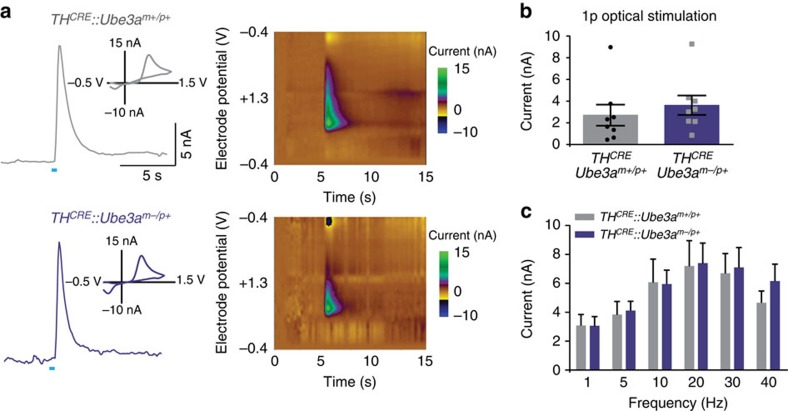
Optically evoked dopamine release is similar in TH-positive VTA-to-NAc terminals in Ube3am−/p+ and Ube3am+/p+ mice.(a) Representative fast-scan voltammetric recordings from ventral striatal slices in both THCRE::Ube3am−/p+ and THCRE::Ube3am+/p+ mice. Insets represent background-subtracted electrochemical signal characteristic of oxidized dopamine. Right: consecutive background-subtracted voltammogram recorded over an 8-s interval. Applied electrode potential (Eapps versus Ag/AgCl reference electrode) is shown versus time. (b) Light-evoked current is similar in both genotypes at 1 pulse (Student's t-test, P=0.99, n=8, 9) and (c) across a range of frequencies (one-way ANOVA, P=0.83, n=11, 12).